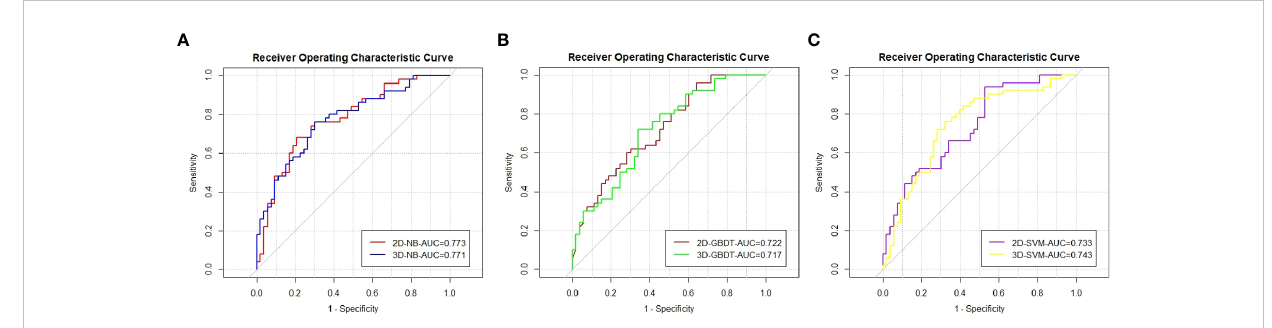
FIGURE 3 The ROC curves and AUC values of the models by the Naive bayes (A) , Gradient boosting decision tree (B) , and Support vector machine (C)